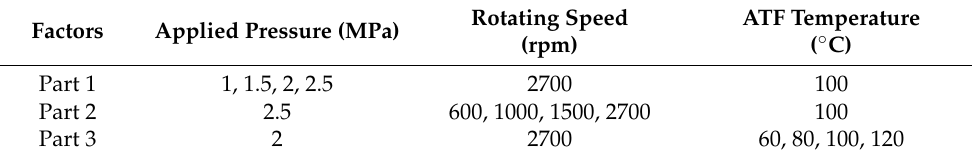
Figure 1. Schematic diagram of the SAE#2 clutch test bench. R-Speed is rotating speed and F-Torque is friction torque. Table 1. Experimental operating conditions of the SAE#2